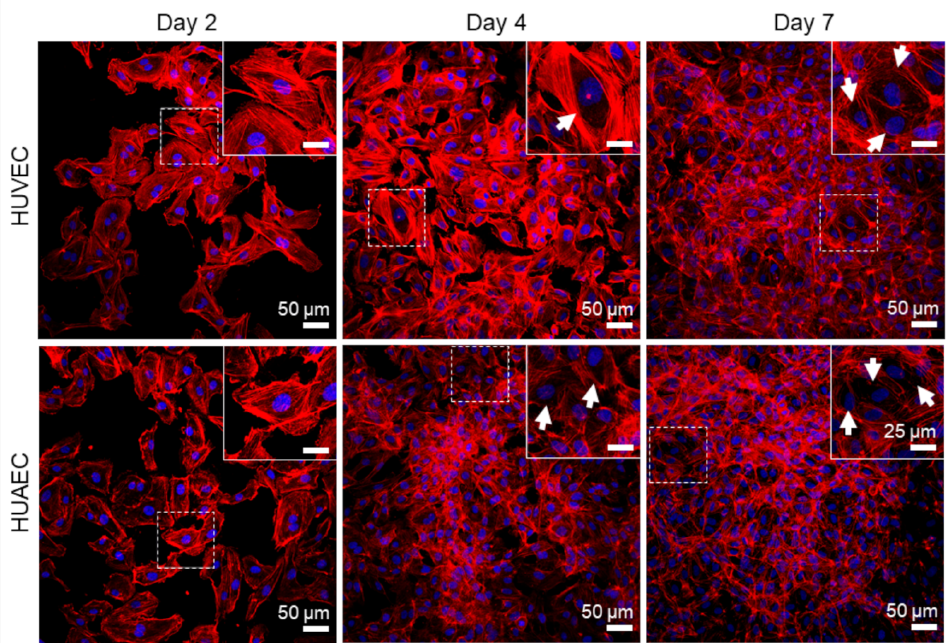
Figure 5. Expression of actin fibers by endothelial cells. Human umbilical cord-derived endothelial cells from veins (HUVEC) or arteries (HUAEC) were seeded at a density of 15,000 cells/well at day 0 and cultivated for 2, 4, and 7 days. While most of the cells exhibited actin fibers throughout the cell body at day 2, an increasing number of cells with pronounced cortical actin fibers were present at day 4 and 7 (indicated by white arrows). Fluorescent images were taken at 20-fold primary magnification. Scale bar represents 50 µ m, and 25 µ m the in magnified image sections in the upper right corner of each image. Squares with dashed lines indicate the image region that was magnified.